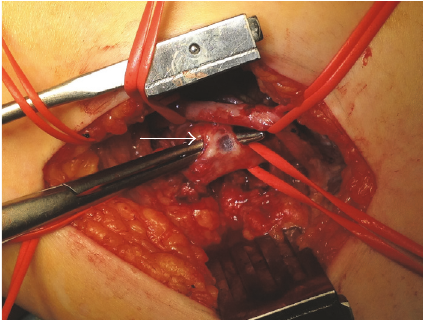
Figure 6: The arrow shows the neck of venous aneurysm. Venous aneurysm of popliteal vein was